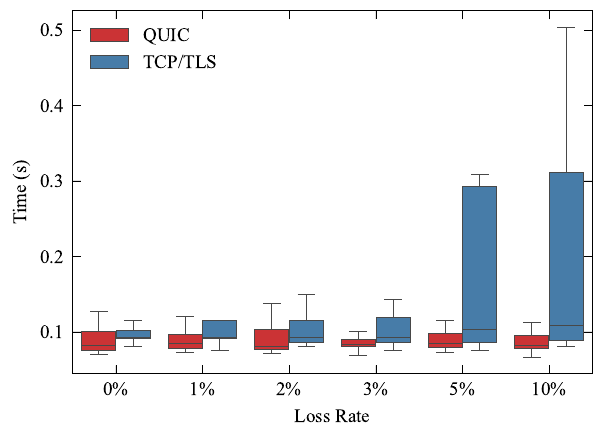
Figure 12. 0-RTT approach on a WiFi network with 8